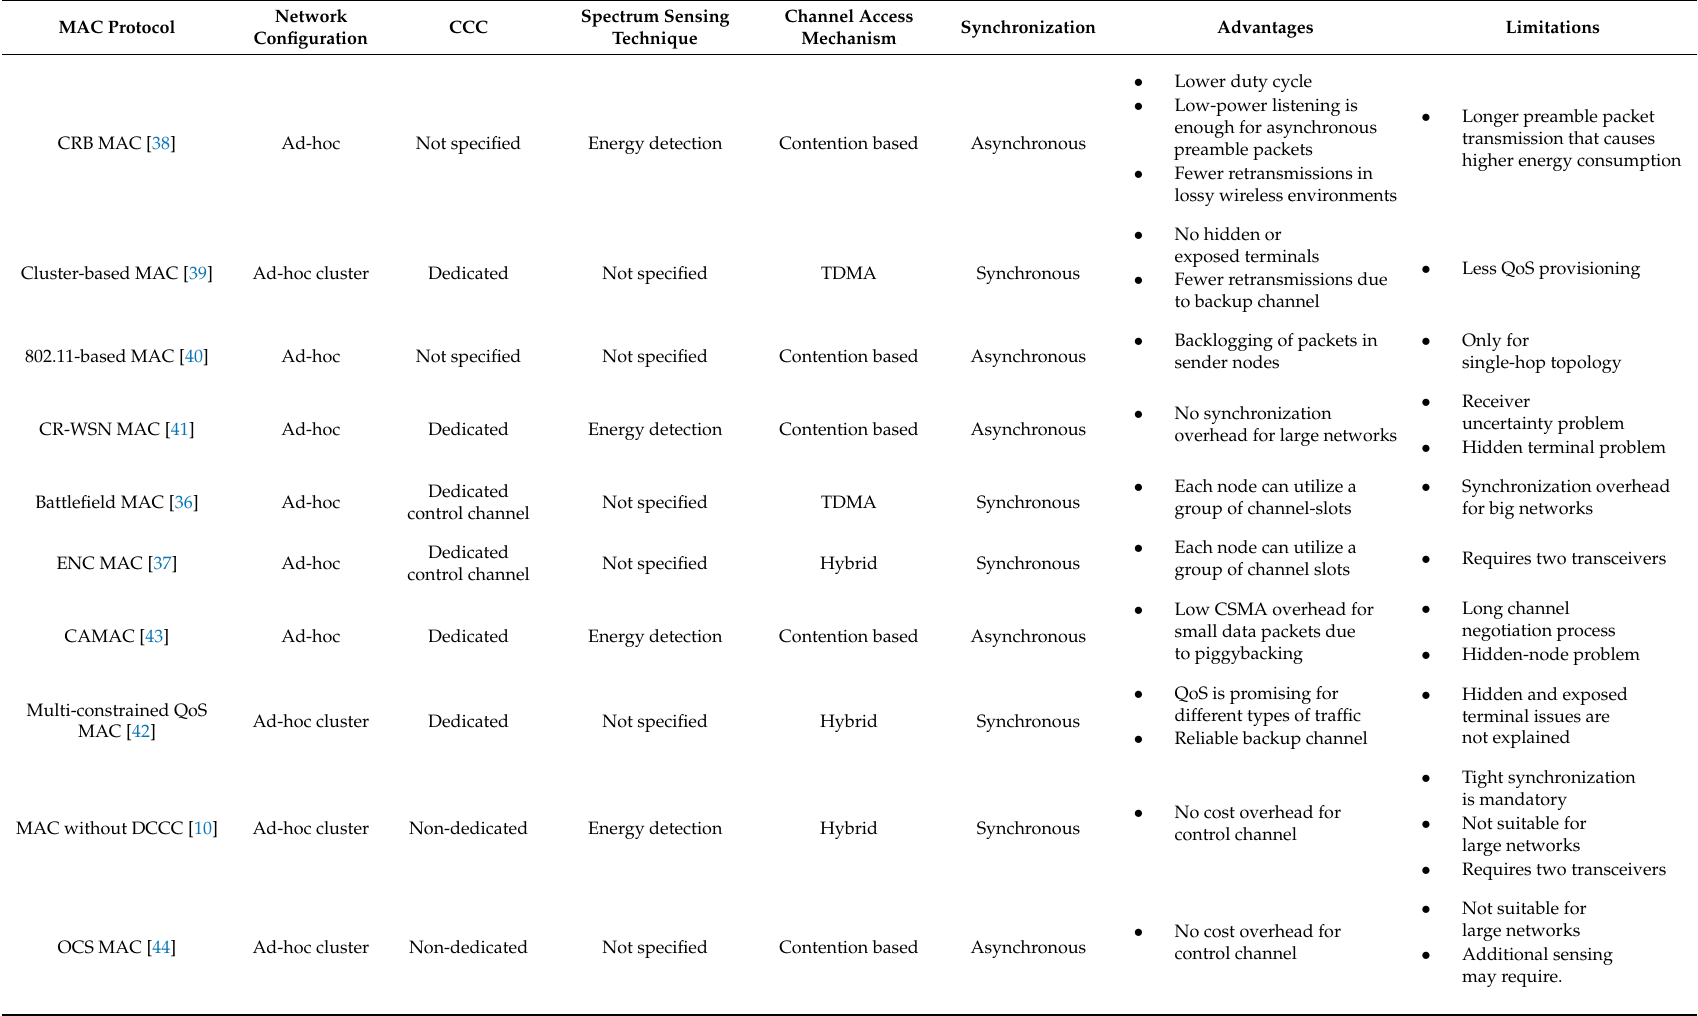
Table 1. Comparison of energy-efficient MAC protocols for